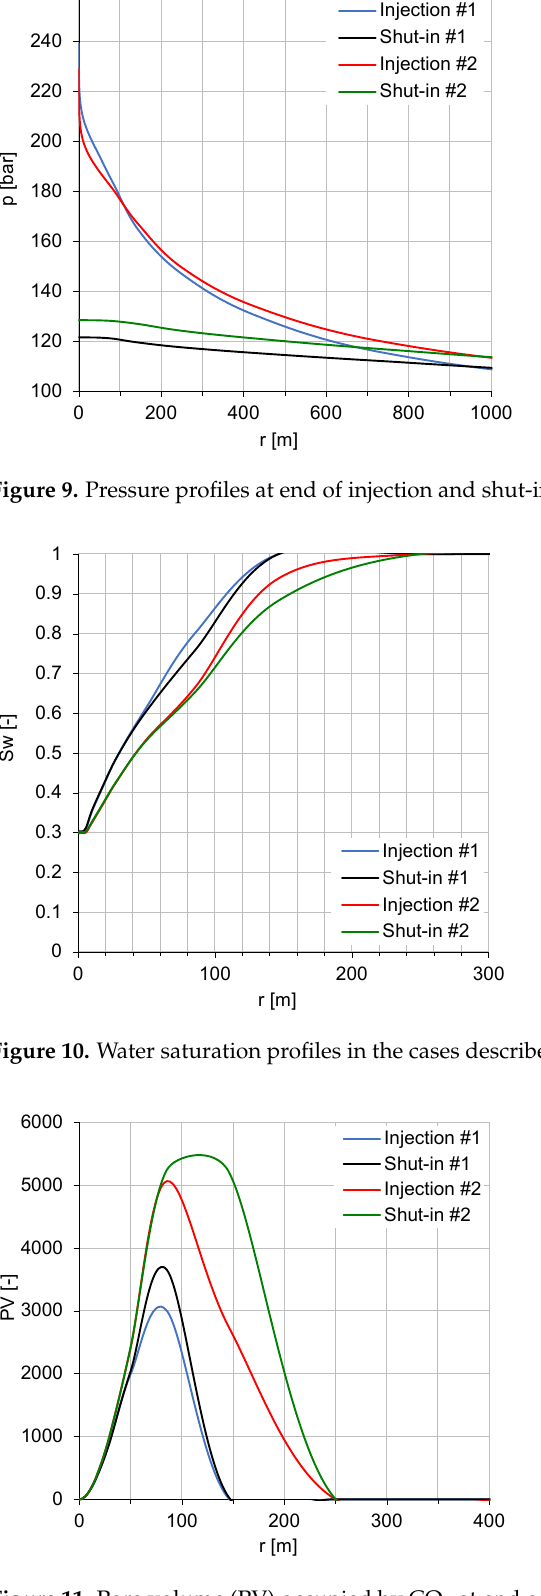
Figure 11. Pore volume (PV) occupied by CO 2 at end of the periods calculated from the saturation profile (Figure 10).